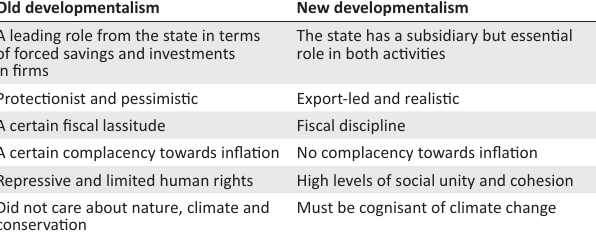
TABLE 1: Old versus new developmentalism: Observations about